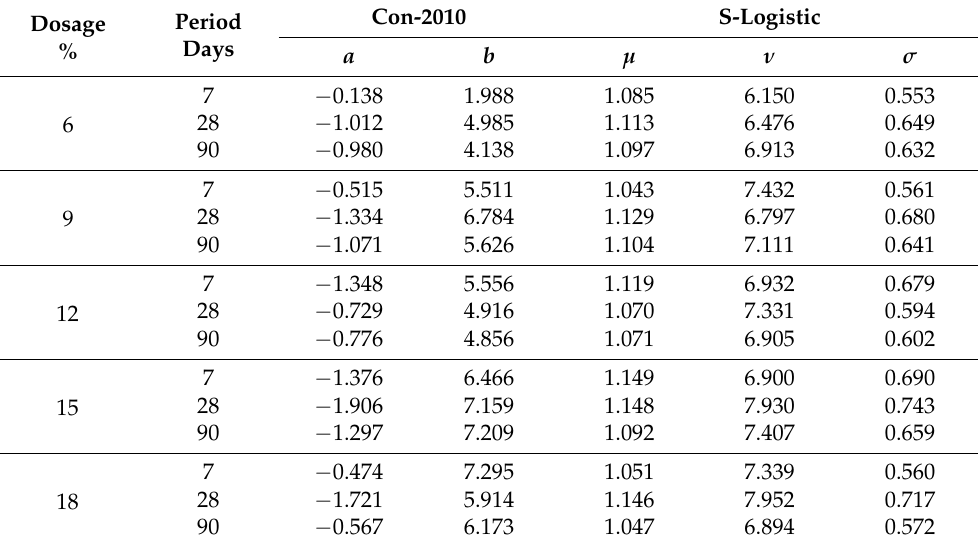
Table 3. The constitutive model parameters calculated by the two